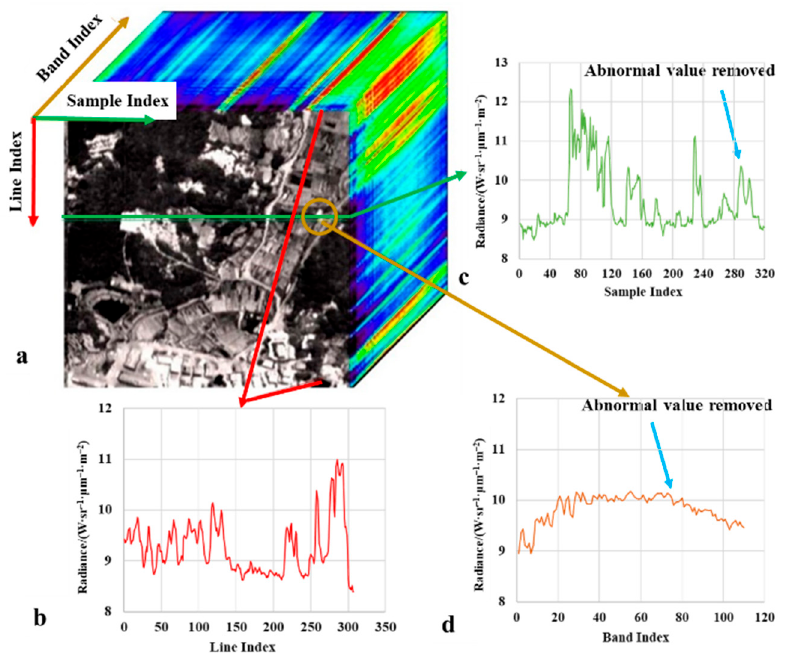
Figure 8. Thermal infrared hyperspectral data cube after blinking pixel repair. ( a ) data cube. ( b ) profile of along the line. ( c ) profile of along the sample. ( d ) spectrum of a specific pixel.